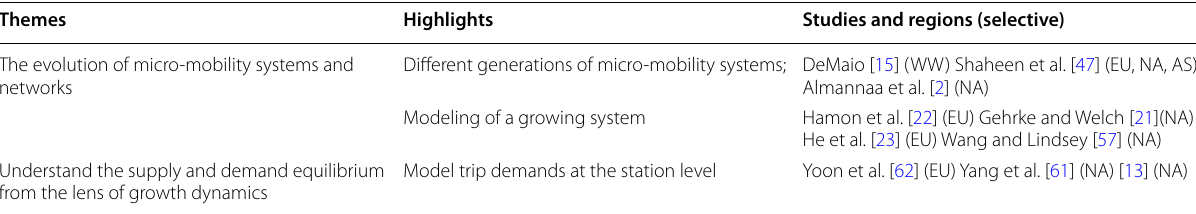
AS—Asia; EU—Europe; NA—North America; OC—Oceania; WW—worldwide